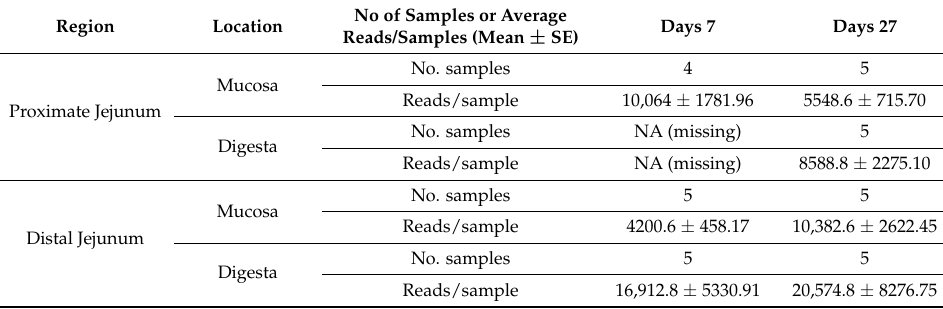
Table 1. Summary of the sequence reads. NA refers to the missing